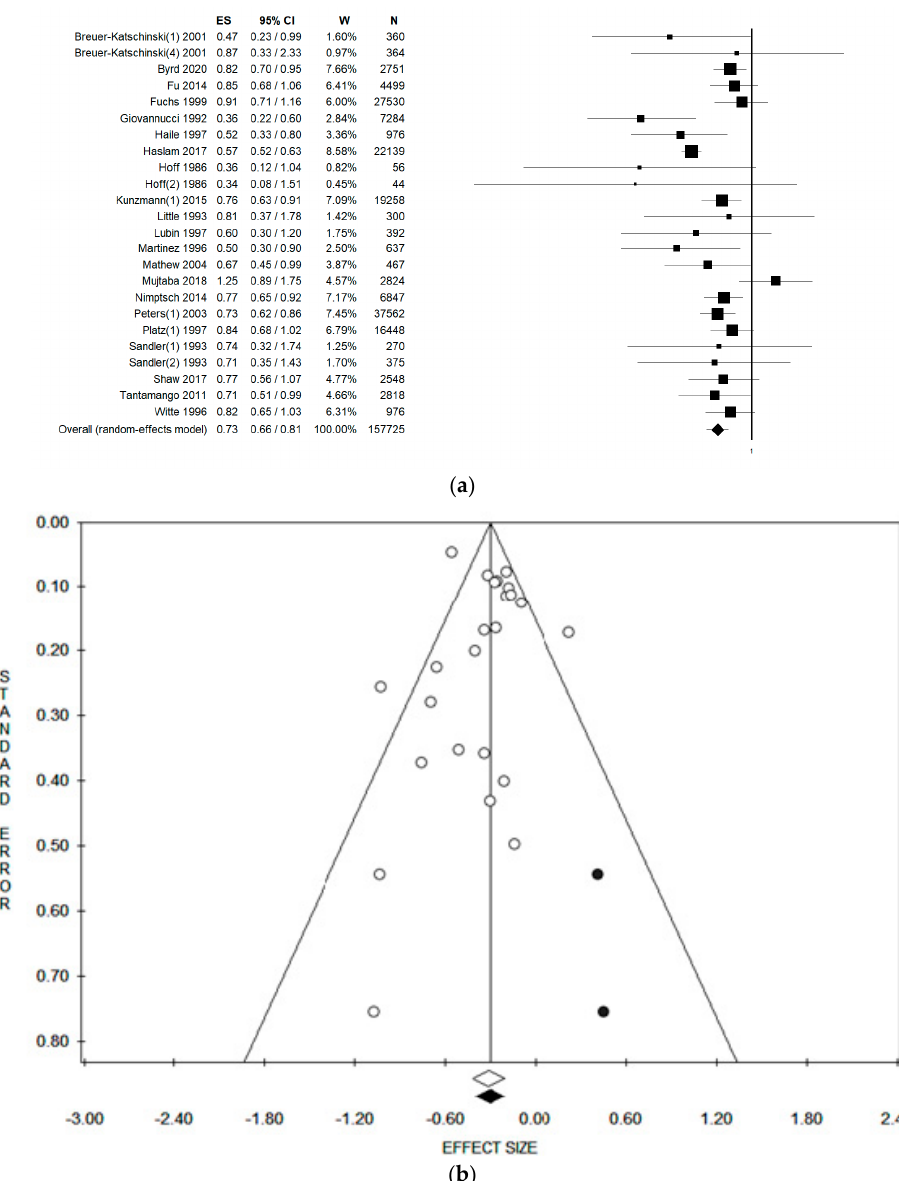
Figure 2. ( a ) Forest plot and ( b ) Funnel plot (after trim and fill method) of the meta-analysis comparing dietary fibre intake (lower vs higher intake) and risk of colorectal adenoma (random effect model). In ( a ) squares represent the effect size values of the individual studies. In ( b ) white dots represent single studies included. The black dots represent estimated studies after the trim and fill method. The white diamond represents the overall effect size of the included studies. The black diamond represents the estimated overall effect size after the trim and fill method.